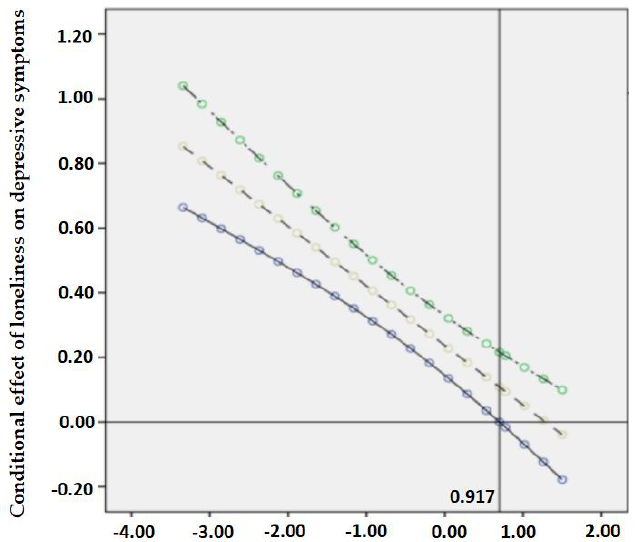
Figure 2. A plot of the effect of loneliness on depressive symptoms versus resilience, with confidence bands. * The curves above and below the line are the upper and lower 95%CI. The horizontal line denotes a conditional effect of zero. The vertical line represents the boundary of the region of significance, similarly hereafter.